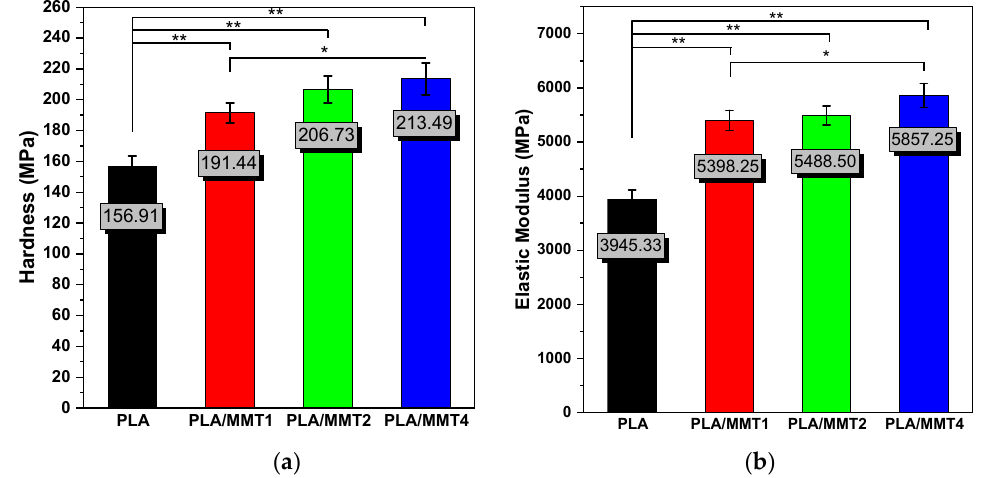
Figure 9. Effect of MMT content on the ( a ) hardness and ( b ) elastic modulus of PLA/MMT filaments. * p ≤ 0.05, ** p ≤ 0.01.